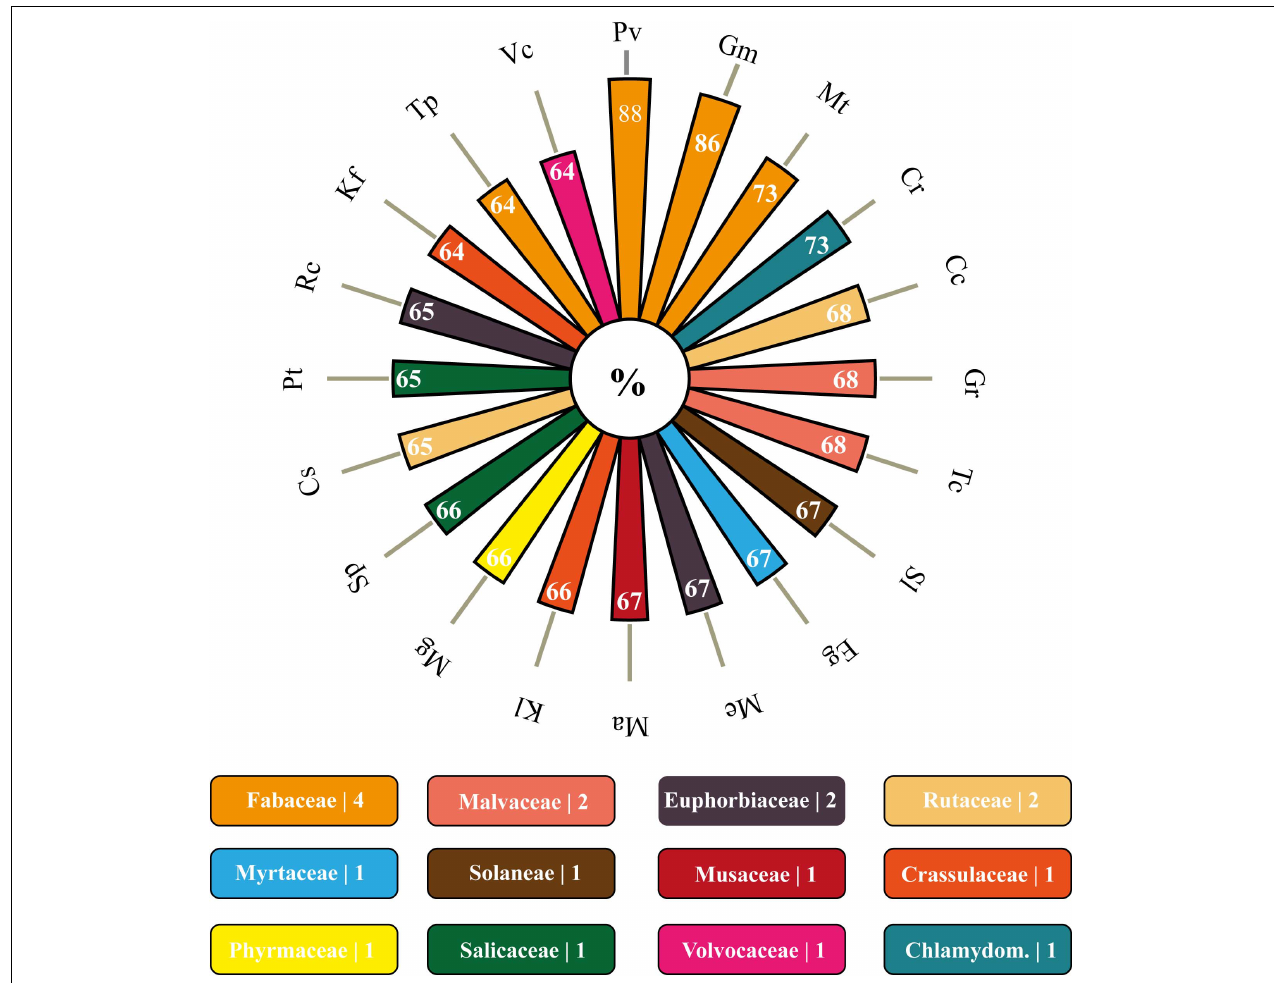
FIGURE 3 | Polar bar chart with 20 species with higher orthology indexes to the bona fide VuPKs identified in the cowpea genome. In rectangles below, are the families covered by these 20 species as well as the number of representatives on the graph above. Corresponding colors between items on the polar bar chart and rectangles perform the association species–family. Pv, Phaseolus vulgaris ; Gm, Glycine max ; Mt, Medicago truncatula ; Cr, Capsella rubella ; Cc, Citrus clementina ; Gr, Gossypium raimondii ; Tc, Theobroma cacao ; Sl, Solanum lycopersicum ; Eg, Eucalyptus grandis ; Me, Manihot esculenta ; Ma, Musa acuminata ; Kl, Kalanchoe laxiflora ; Mg, Mimulus guttatus ; Sp, Salix purpurea ; Cs, Citrus sinensis ; Pt, Populus trichocarpa ; Rc, Ricinus communis ; Kf, Kalanchoe fedtschenkoi ; Tp, Trifolium pratense ; Vc, Volvox carteri